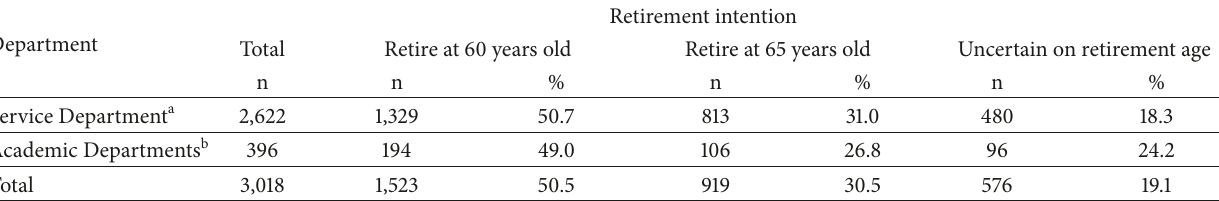
Table 1: Proportions of registered nurses who intend to extend their working life